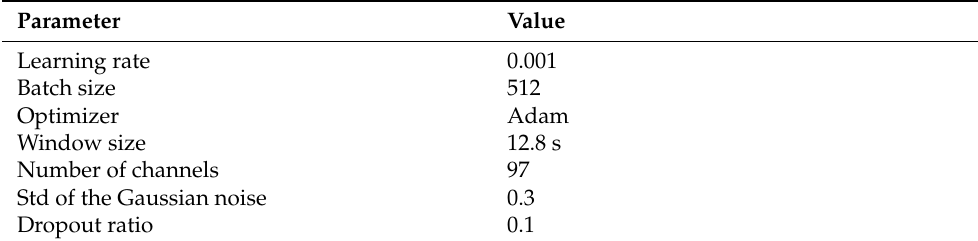
Figure 6. Schematic representation of the RPCNN model architecture. Table 4. Overview of the RPCNN model training